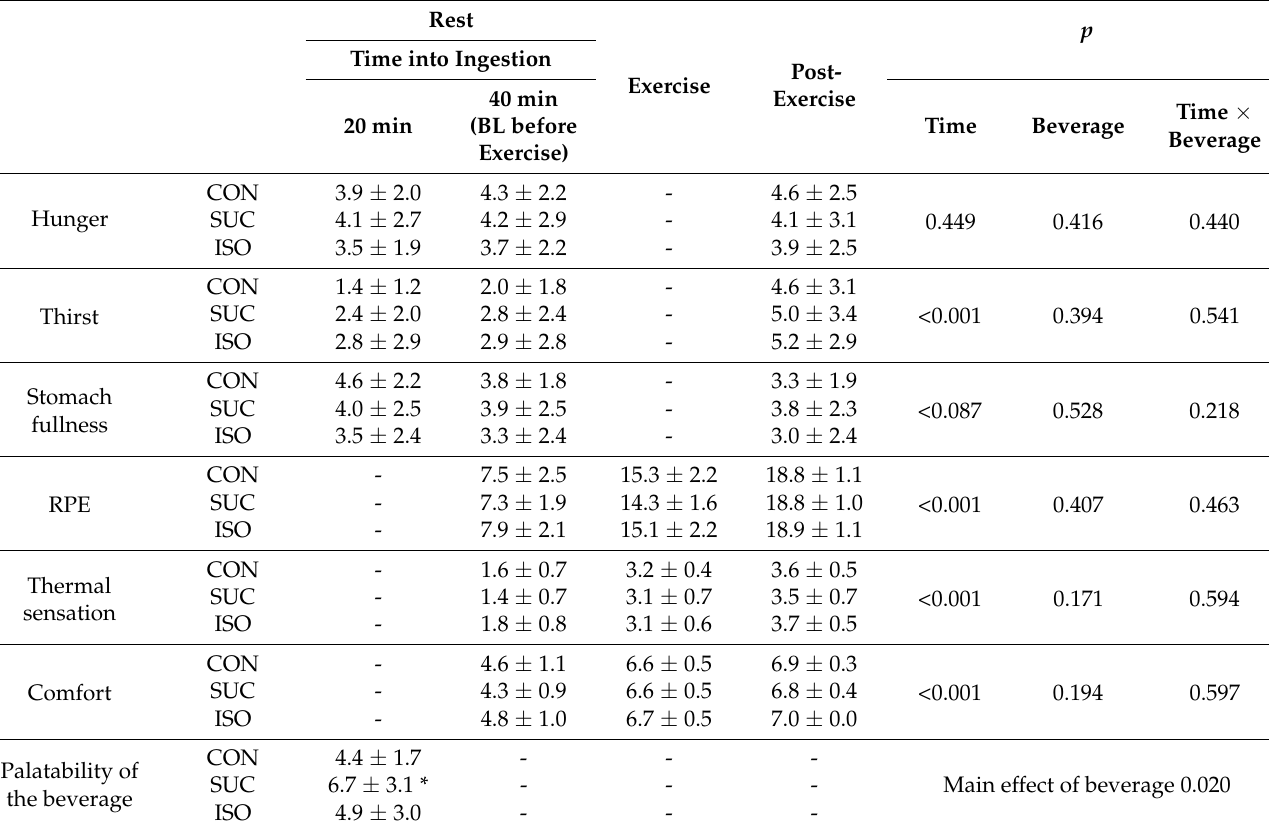
Table 4. Subjective feelings at rest and after exercise in each